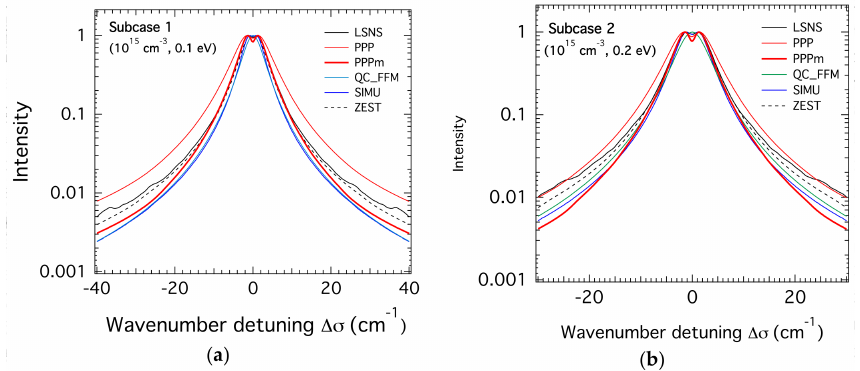
Figure 8. The theoretical Stark profiles of the H- β line of Figures 1 and 2 with the inclusion of the modified PPP calculations (PPPm: thick red solid line) where the electron density was scaled down by the mean corresponding factor explained at the end of Section 3.3. The same factor of 1.5 was used for both subcases ( a ) T e = T i = 0.1 eV ( b ) T e = T i = 0.2